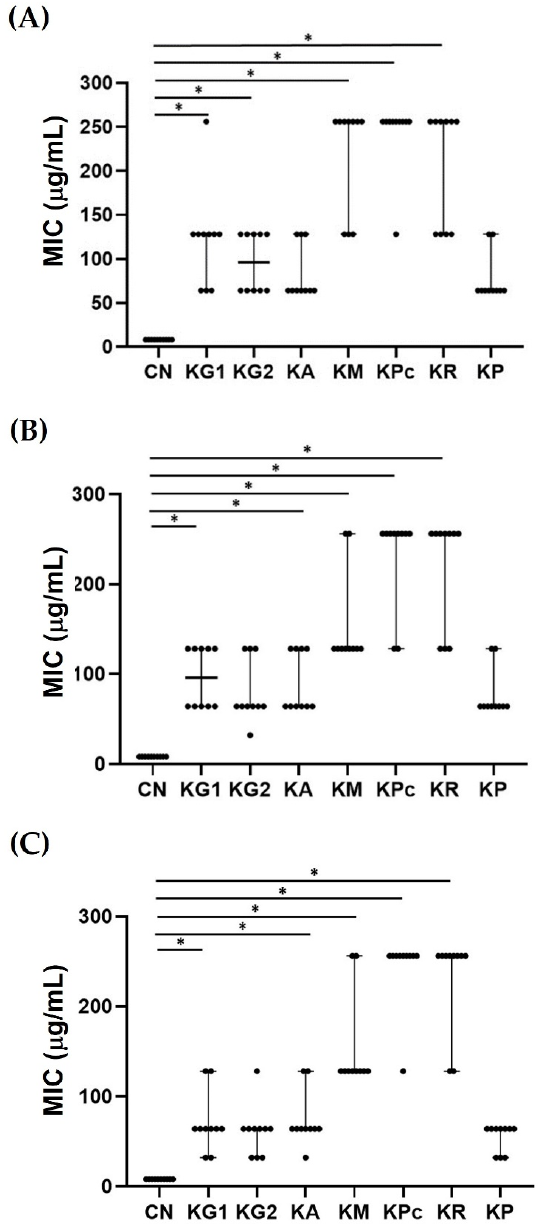
Figure 1. Scatter dot plot showing median values with 95% CI of minimal inhibitory concentration ( n = 10) of crude Kaempferia extracts ( Kaempferia galangal L. (KG1), Kaempferia galanga L. (KG2, Kaempferia angustifolia Roscoe (KA), Kaempferia marginata Carey (KM), Kaempferia pulchra Ridl (KPc), Kaempferia rotunda L (KR), and Kaempferia parviflora Wall. Ex Baker (KP)), compared to gentamicin (CN) after being separately tested against ( A ) Klebsiella pneumoniae (CRKP), ( B ) Pseudomonas aeruginosa (CRPA), and Acinetobacter baumannii (CRAB) ( C ). *, Significant difference apart from CN at p ≤ 0.05.